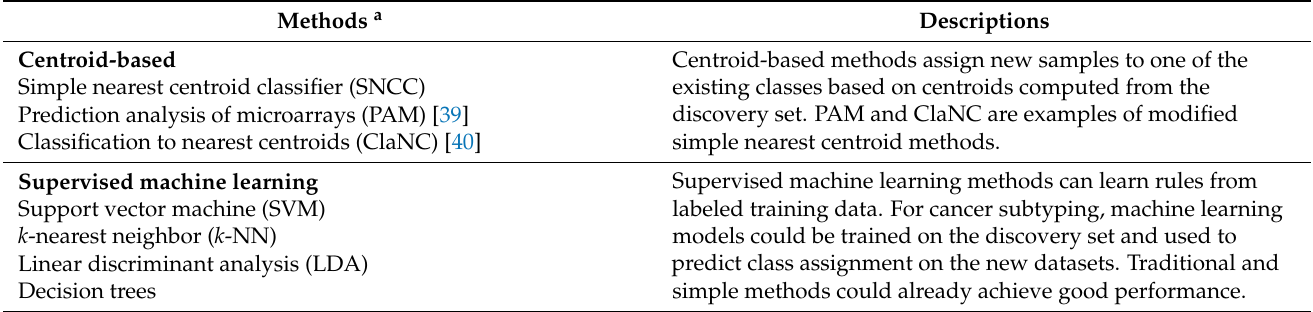
Table 2. Algorithms for subtype